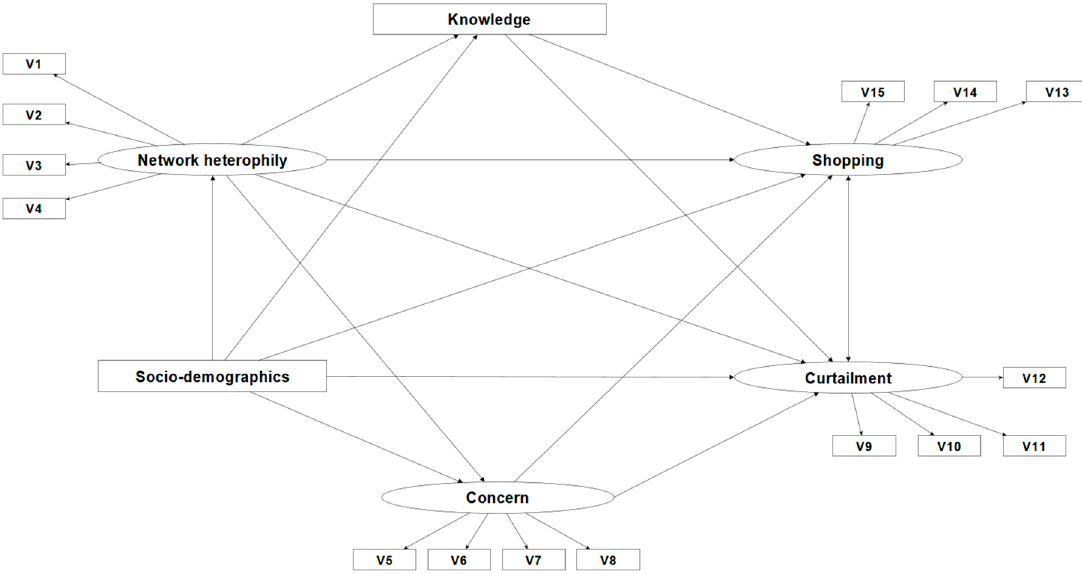
Figure 3. Structural model: visual representation of structural model estimation. Model fit: χ 2 = 327.065 df = 162, p ≤ 0.001; CFI = 0.971; SRMR = 0.037; RMSEA = 0.029.